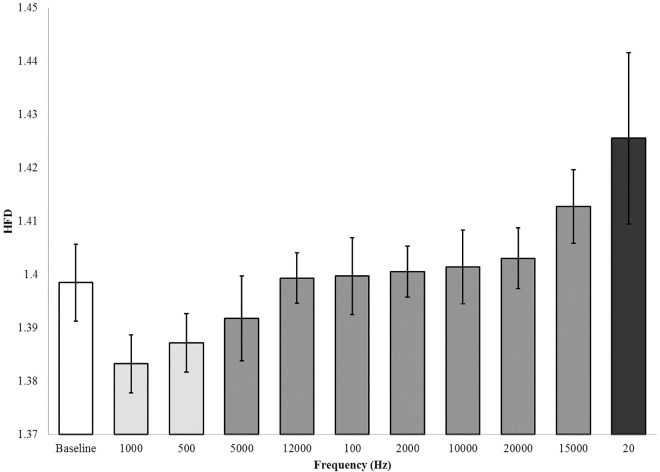
Fractal Dimensions by Frequency: Heschl’s Gyrus.Results of the Higuchi Fractal Dimension (HFD) Kruskall-Wallis test. Groups as revealed by post-hoc Mann-Whitney U tests are indicated by shading of bars, with the exception of the baseline (error bars = SEM).